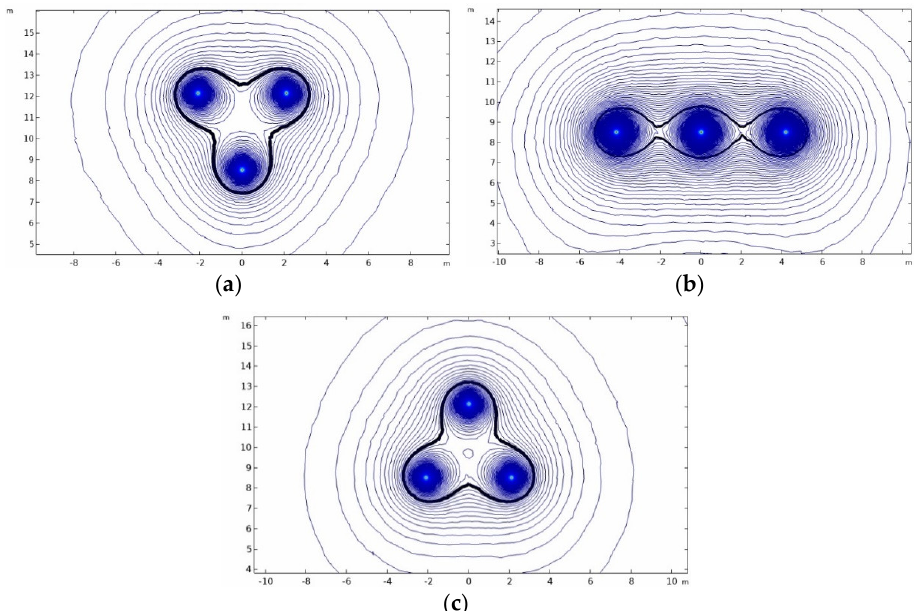
Table 2. Safety distance under different arrangement modes of 10 kV.